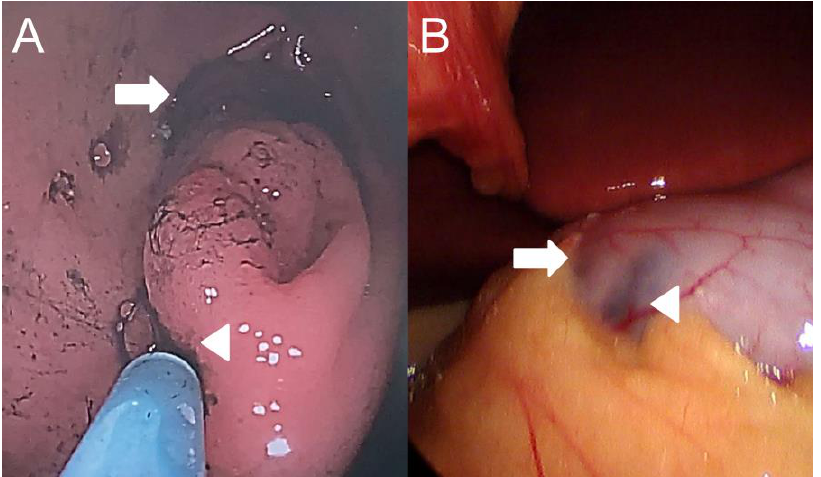
Figure 1. ( A ) Esophagogastroduodenoscopy revealing one oval subepithelial lesion with central umbilication located in the gastric antrum measuring approximately 10 mm in diameter. ( B ) Endo- scopic ultrasonography showing that the lesion was hypoechoic, heterogeneous with ill-defined margins, measuring 4.8 × 2.7 mm in size, arising from the submucosa (arrow).